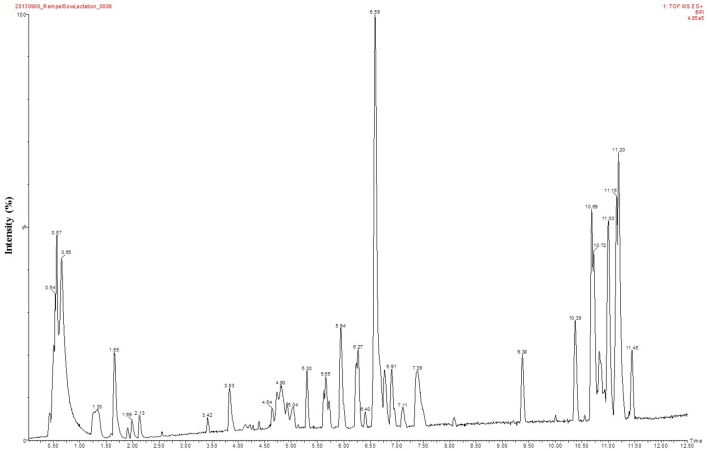
A representative LC-MS base peak chromatogram of plasma collected at post-farrowing from a dam that had minimal body condition loss at the conclusion of lactation (Lo loss). The Y-axis represents the intensity (%) and the X-axis depicts retention time in minutes.